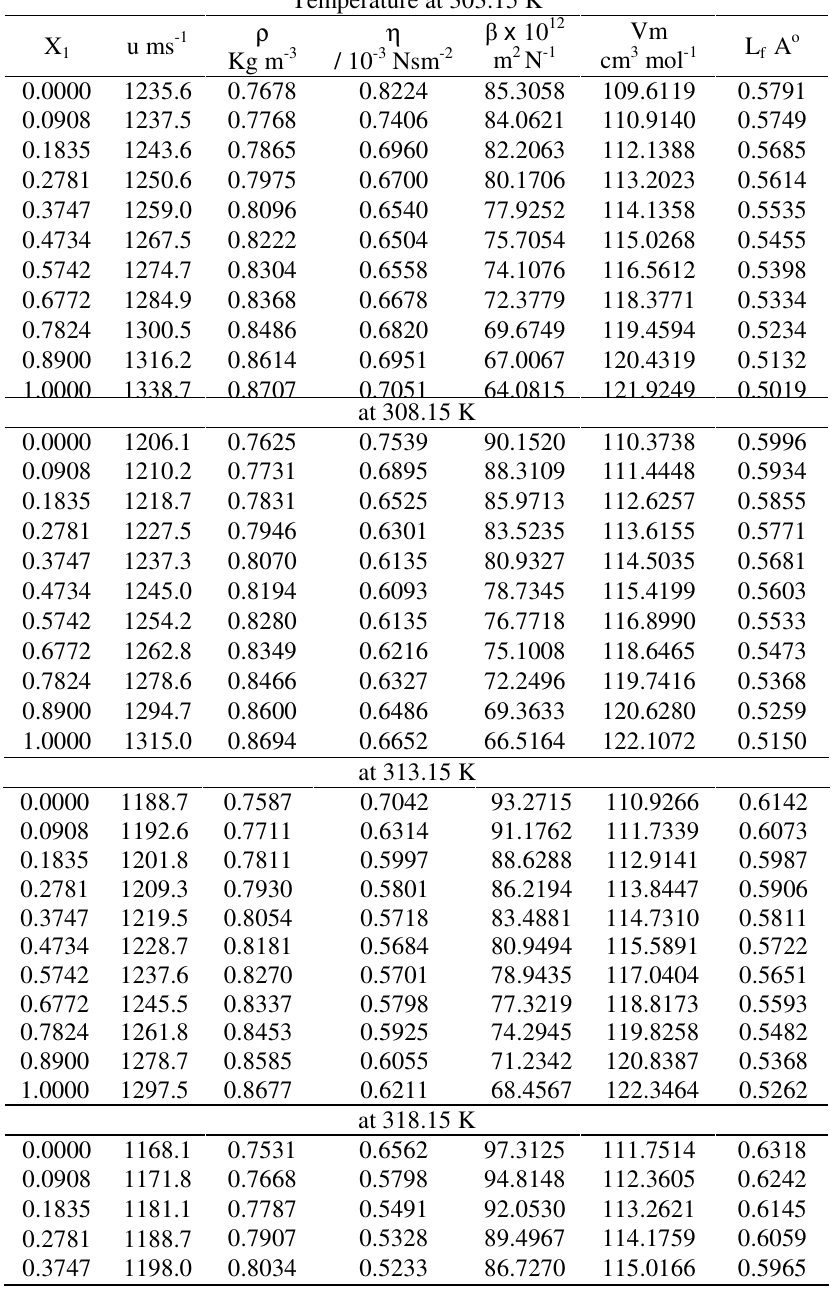
) values for cylohexane with o f